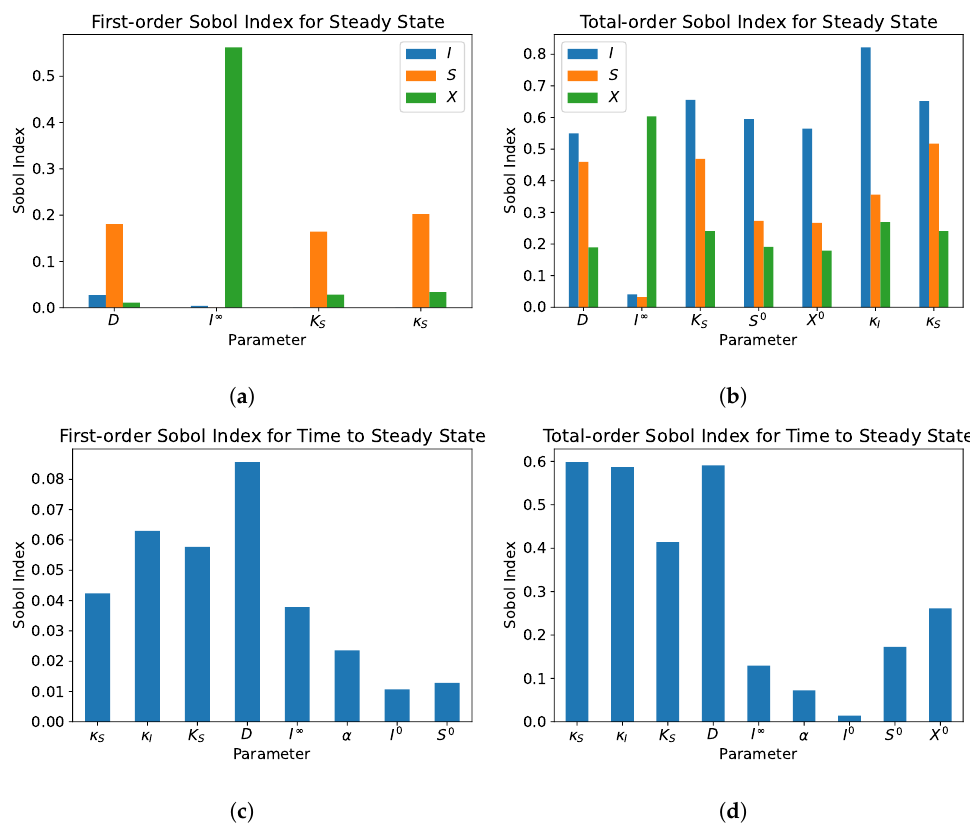
Figure 9. ( a ) First-order and ( b ) total effect sensitivity indices of time to steady state values of fiber I , sugar S and biomass X . ( c ) First-order and ( d ) total effect sensitivity indices of time to steady state values of fiber I , sugar S and biomass X . Sampling was conducted with a variance of 20% on input parameters, excluding yield coefficients. Mean values were taken from Table 1, excluding initial biomass concentration, which was set to X 0 = 0.035. This parameter set captures the saddle-node bifurcation (Figure